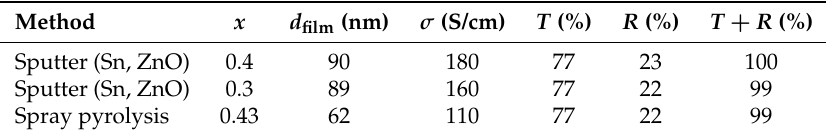
Table 1. Summary of electrical and optical properties of selected ZTO samples shown in Figure 5. The growth method, ZnO content x , specific sample thickness d , conductivity σ , as well as average transmission T , reflection R , and T + R in the range from 1–3eV are listed. All values include the substrate. The relatively low transmission is caused by high reflectivity by interference for the specific film thickness [24]. The film thickness was measured by X-ray reflection. Within the error ( ± 1%) no significant absorption was found in this spectral range.